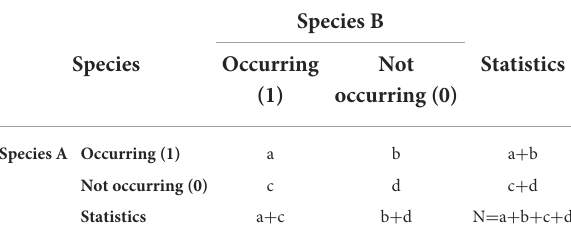
TABLE 1 Determination of inter-species association 2 × 2 contingency table. Species B Species Occurring